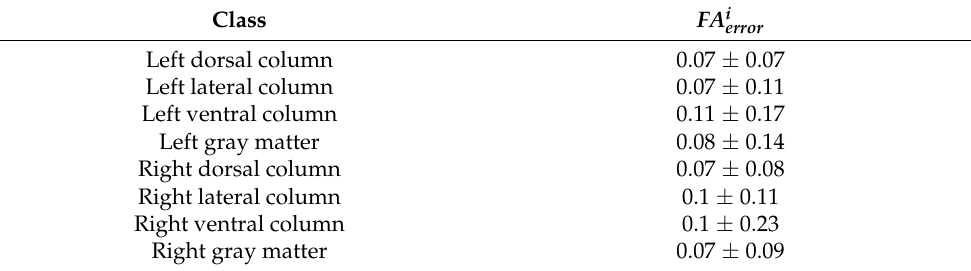
Table 3. The percentage of absolute error between two types of FA